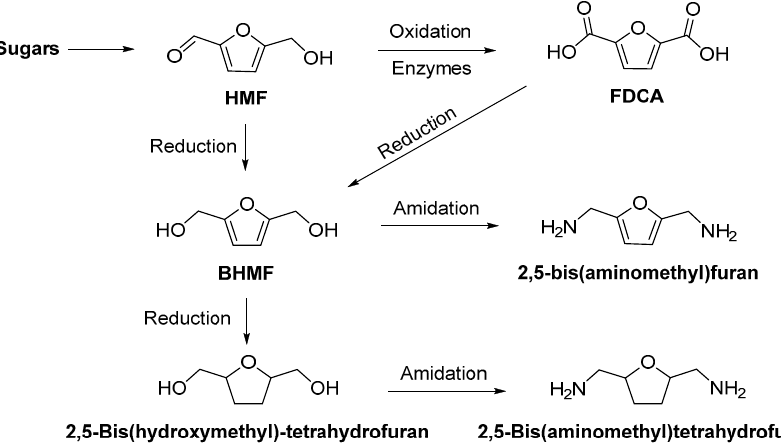
Scheme 7. Promising biobased furan monomers for polyester or polyamide synthesis.